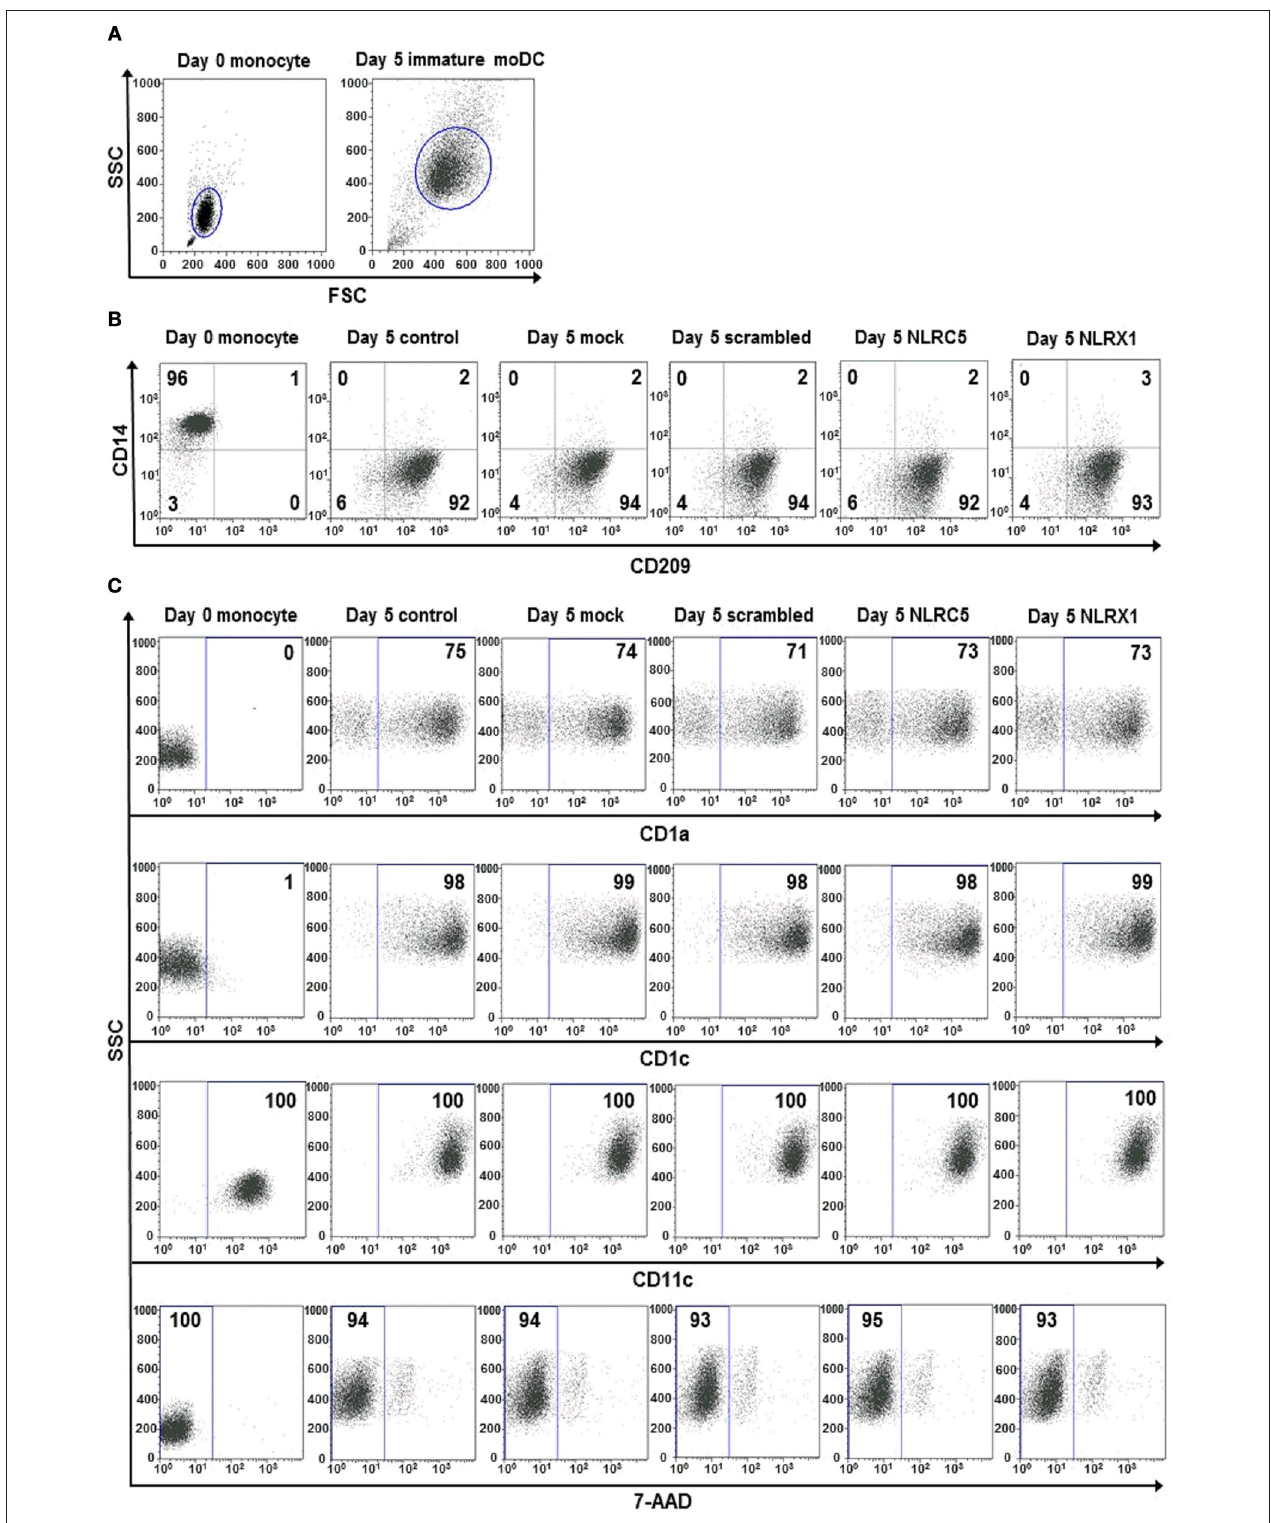
FIGURE 6 | The silencing of NLRC5 or NLRX1 does not influence the differentiation process of human immature moDCs. (A–C) Freshly isolated monocytes were transfected with siRNAs specific for NLRC5, NLRX1, or scrambled (scr) siRNAs at day 0 and differentiated into immature moDCs. On day 5 of differentiation